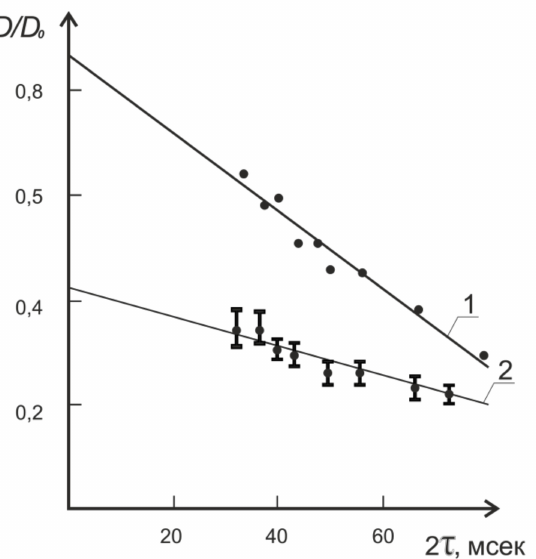
Figure 5. Dependence of relative self-diffusion coefficient on observation time 2 τ for Zea mays (1) and for frog liver (2) at 25 ◦ C (Adapted from